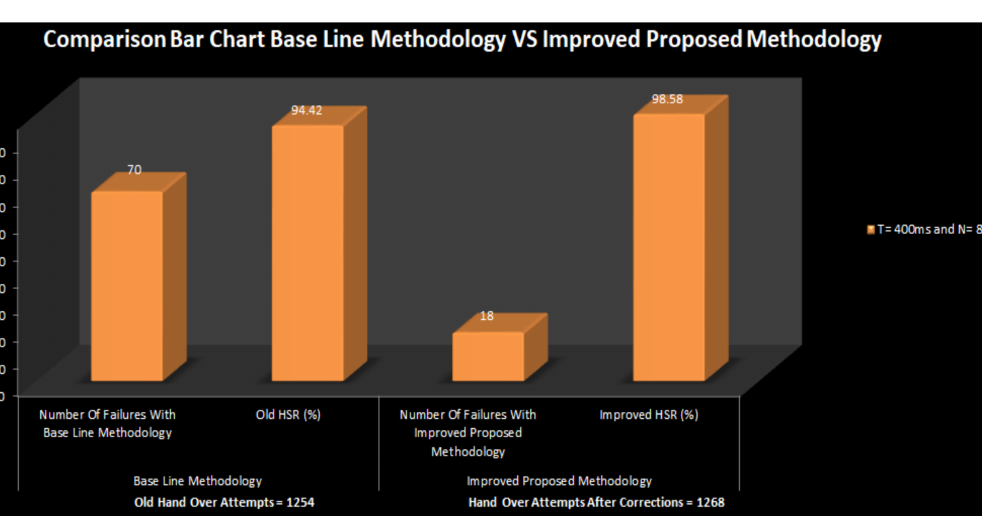
Figure 11. Comparison bar chart.